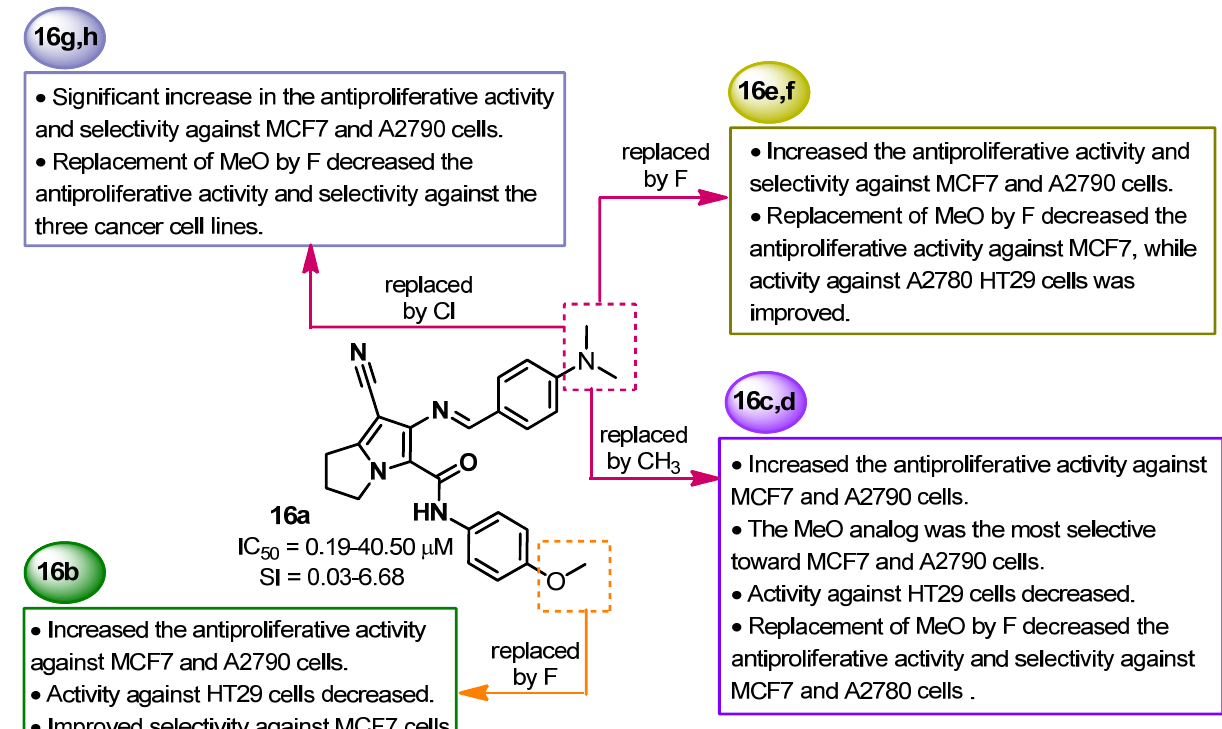
Figure 10. SAR of the antiproliferative activity/selectivity of compounds 16a – h.